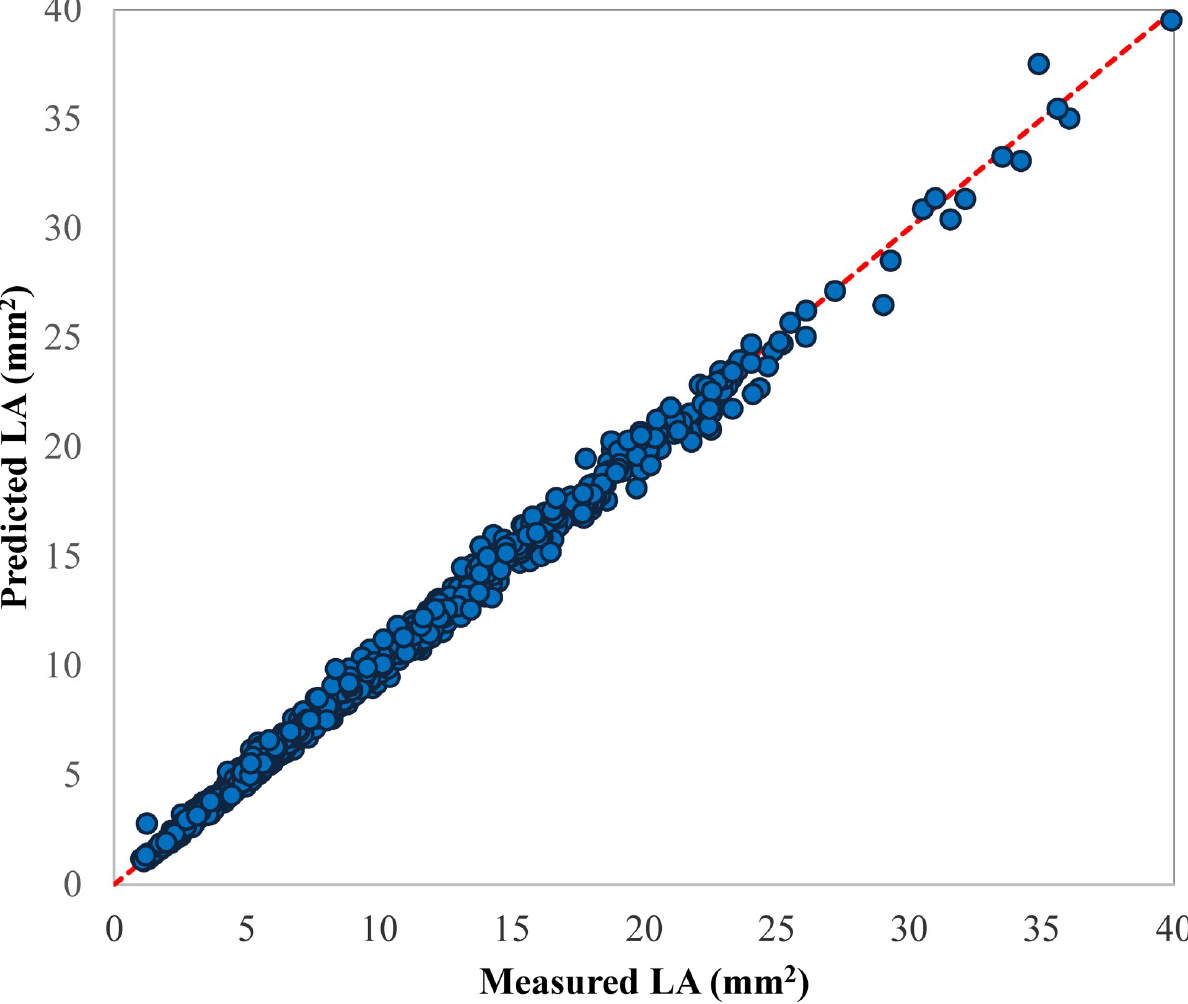
Fig 4. Scatter plot of the estimated LA values by LA = 0.007 + 0.687 L × W model vs. the corresponding measured LA values of 2019 dataset.